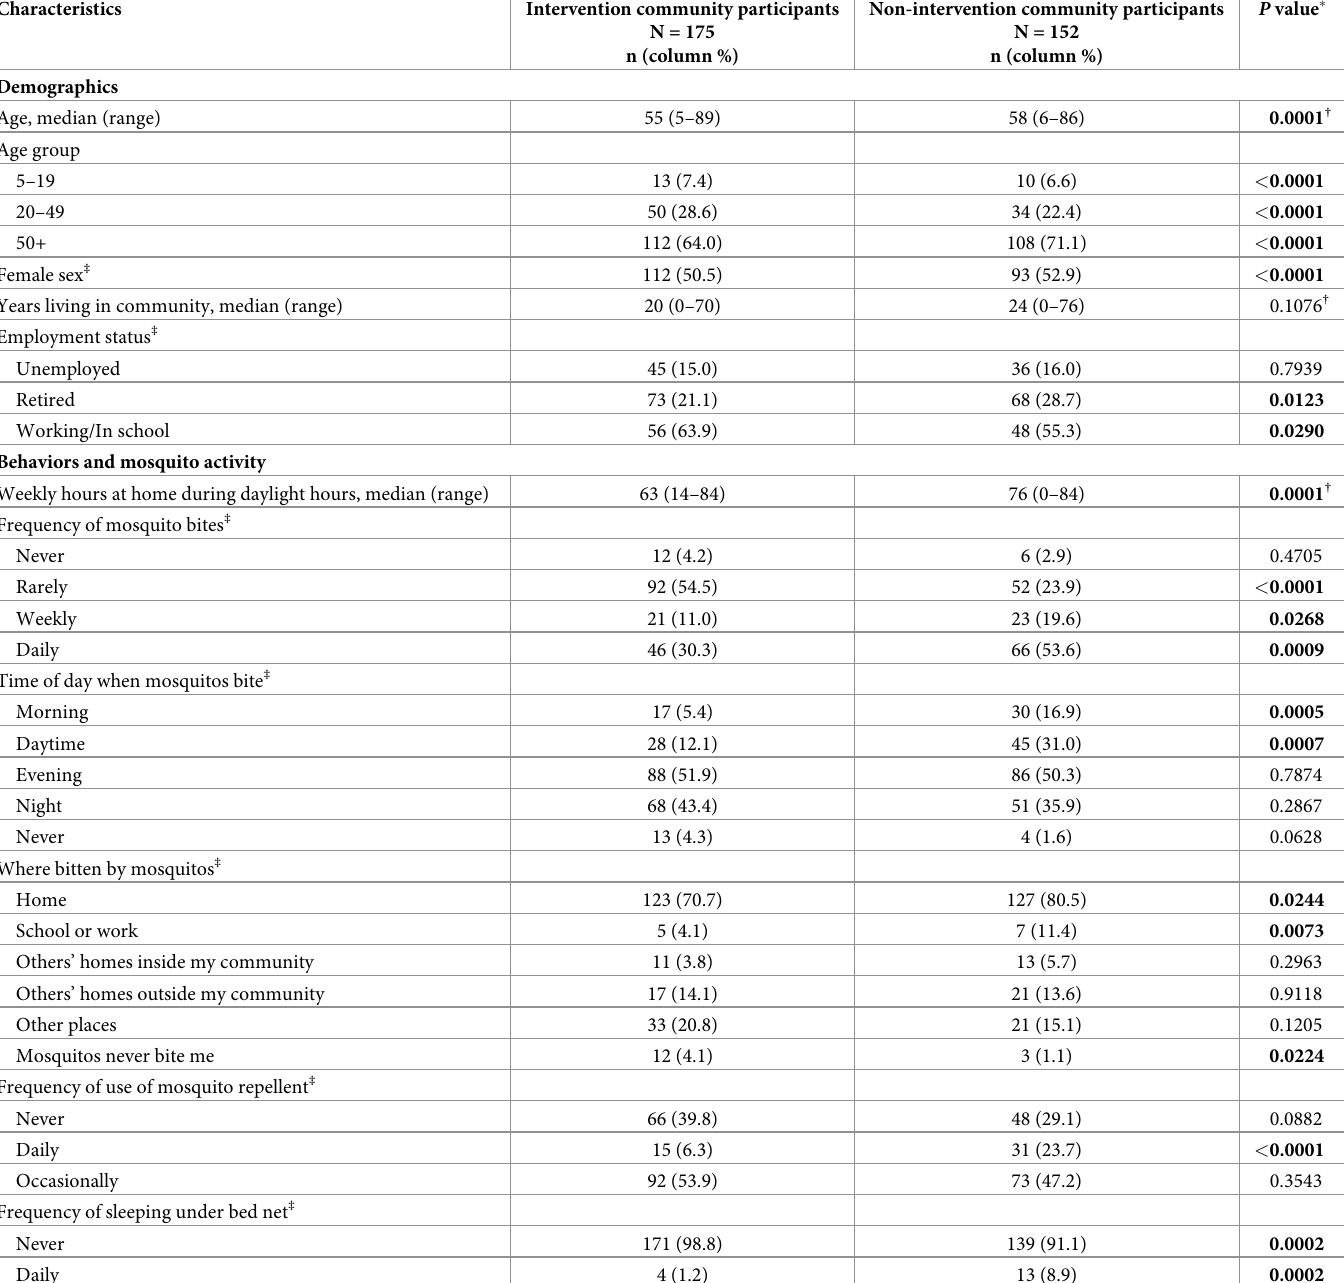
Table 1. Comparison of demographic characteristics and reported behaviors among participants of a survey of chikungunya virus seroprevalence among communi- ties with (intervention) or without (non-intervention) autocidal gravid ovitraps (AGO traps) in Puerto Rico, November 2015–February 2016.